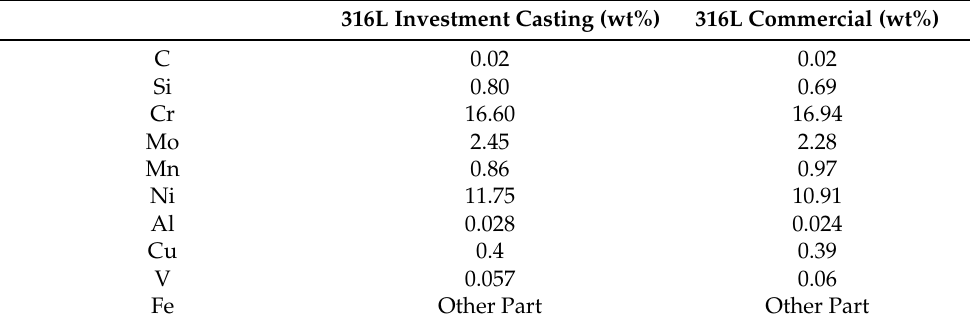
Table 1. Chemical composition of 316L material used in experiments.